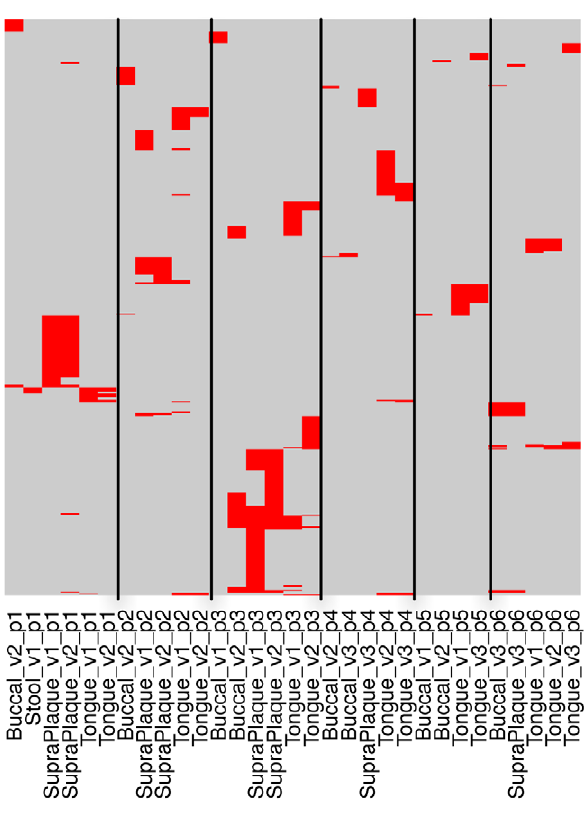
Figure 5. Sharing of streptococcal CRISPR spacers among samples from 6 individuals. In this map, the rows are the 761 spacers (clustered at 98% identify) identified in one or more of these 6 individuals, and the columns are samples ( e.g. , Stool_v1_p1 indicates a sample from stool of individual 1, in visit 1; Tongue_v2_p1 indicates dataset from tongue, individual 1, in visit 2). Buccal stands for buccal mucosa, and SupraPlaque stands for supragingival plaque. The red lines indicate the presence of spacers in each of the samples. Multiple lines in the same row represent a spacer that is shared by multiple samples.